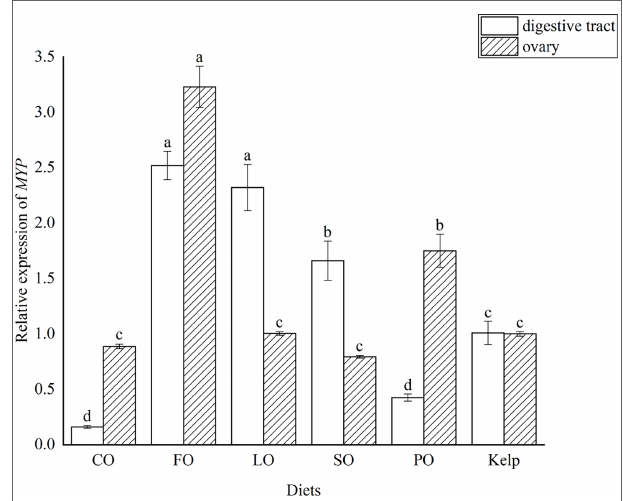
FIGURE 4 | Effects of dietary lipid sources (colza oil (CO), fish oil (FO), linseed oil (LO), soybean oil (SO), or palm oil (PO)) on the major yolk protein (MYP) expression in sea urchin ( Strongylocentrotus intermedius ) (mean ± SEM, n=3). Mean value bars bearing with different lowercase letters are significantly different at P <